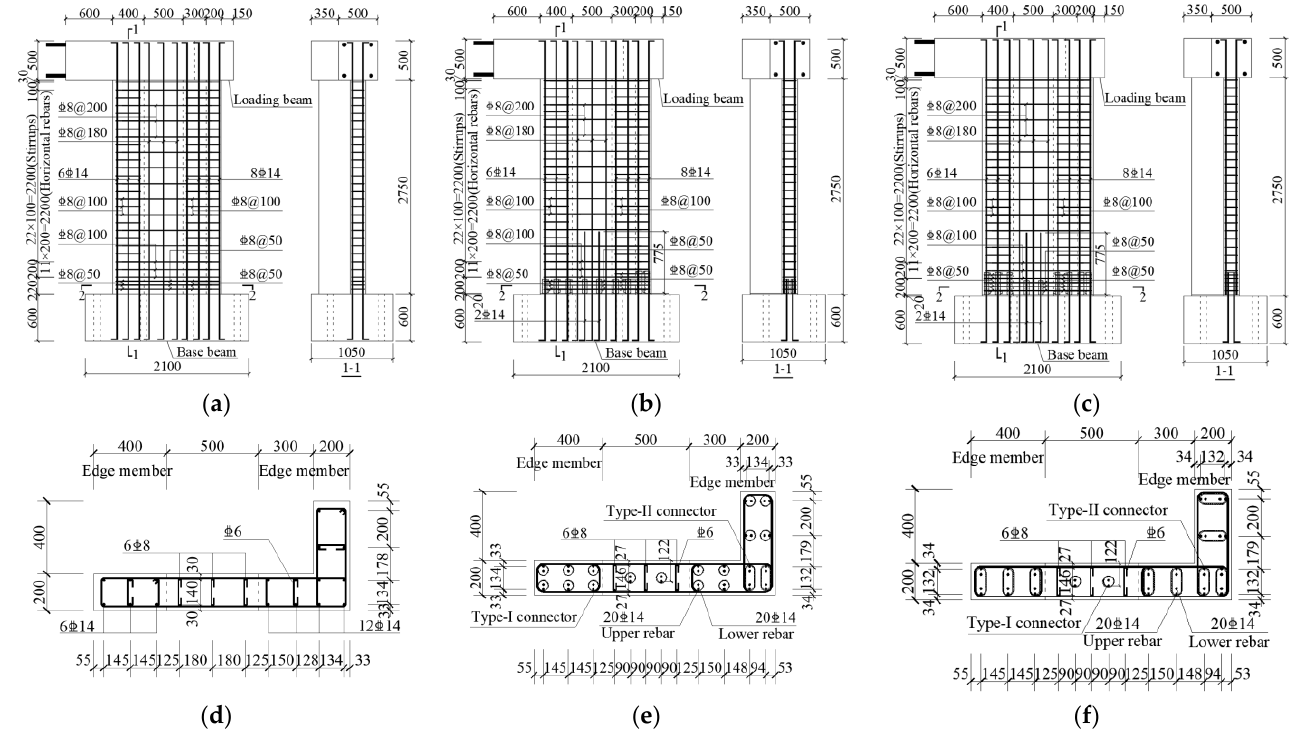
Figure 2. Dimensions and reinforcements of specimens ( a ) Facade of LSW, ( b ) Facade of LAPC-1, ( c ) Facade of LAPC-2, ( d ) Section of LSW, ( e ) Section of LAPC-1, ( f ) Section of LAPC-2.